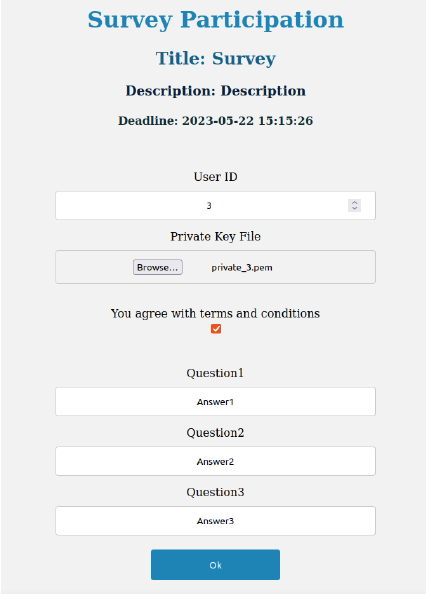
Figure 4. Answer